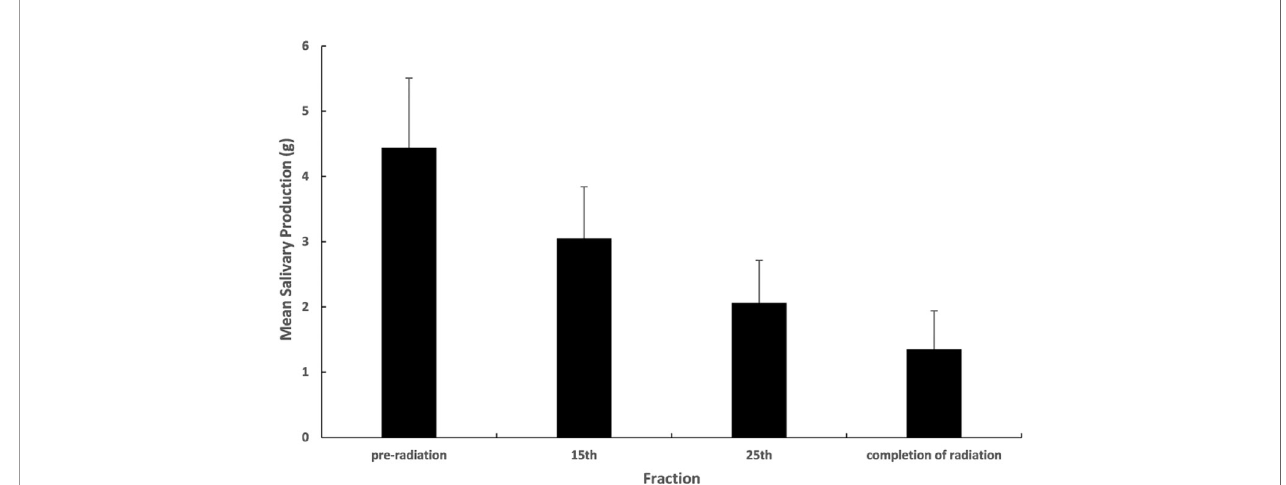
FIGURE 1 | Mean salivary production during radiotherapy of chewing stimulating test.